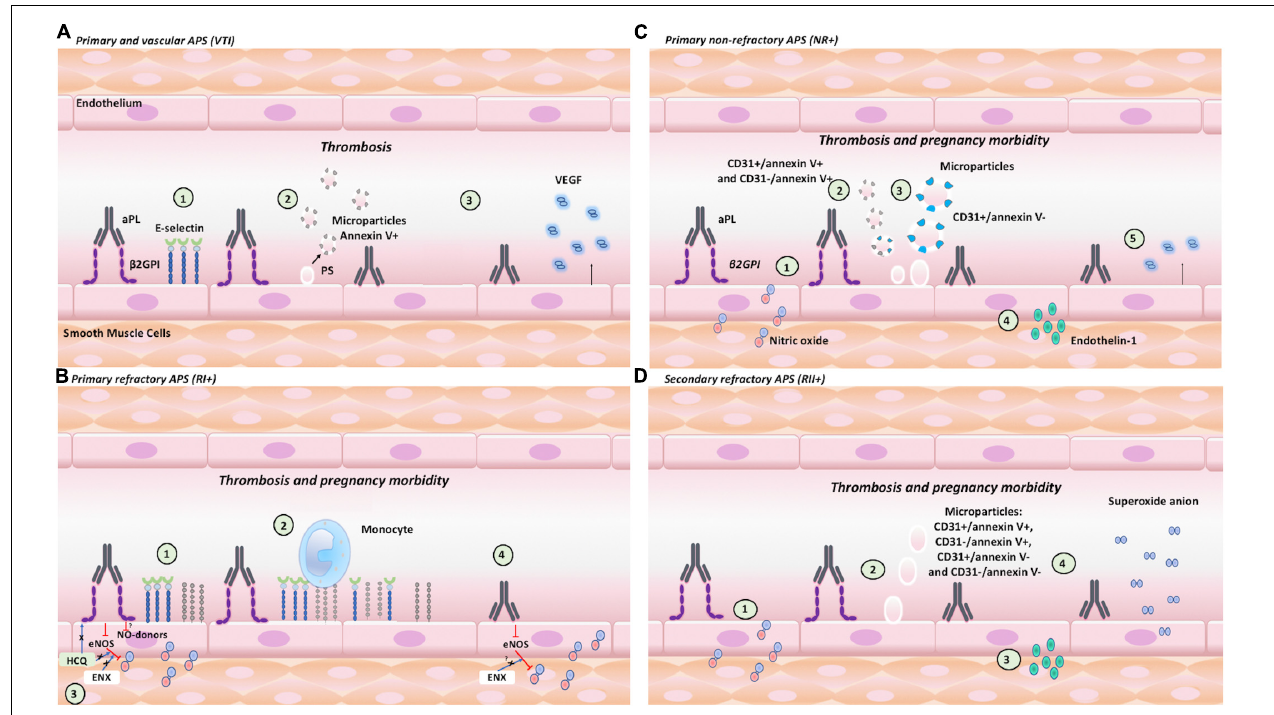
FIGURE 8 | Endothelial activation and dysfunction in APS: clinical manifestation association and role of β 2GPI. The pathogenetic effects associated with endothelial activation induced by aPL with or without β 2GPI contribute to thrombosis or pregnancy morbidity. (A) VTI + IgG: (1) increased the expression of E-selectin; (2) generated positive annexin V procoagulant MPs of 0.5 µ m; and (3) increased the VEGF generation. (B) RI + IgG: (1) increased the expression of E-selectin and VCAM; (2) induced monocyte adhesion; (3) decreased NO bioavailability, which was modulated by HCQ and ENX; and (4) decreased NO bioavailability, which was modulated by ENX. (C) NR + IgG: (1) decreased NO bioavailability; (2) increased the number of 0.5- µ m procoagulant MPs (CD31+/annexinV+ and CD31-/annexinV+); (3) increased CD31+/annexinV, MP of 1 µ m; (4) increased endothelin-1 production; and (5) reduced VEGF. (D) RII + IgG: (1) decreased NO bioavailability; (2) increased MPs of 1 µ m; (3) generated endothelin-1 production; and (4) induced oxidative stress (mitochondrial O 2 −